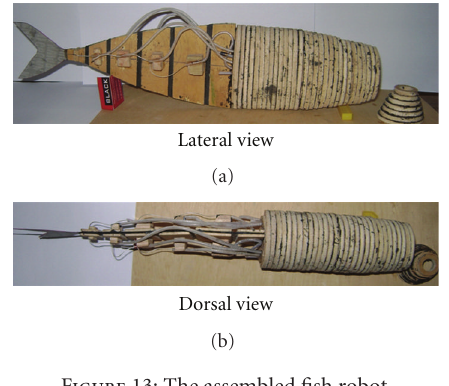
Figure 13: The assembled fish robot.